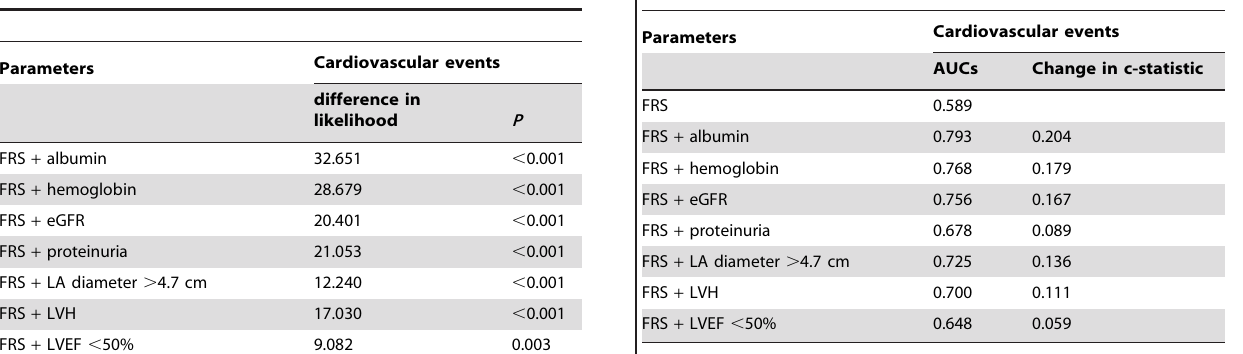
Table 3. Incremental values of biomarkers and echocardiographic parameters for cardiovascular events when added to the FRS model using Cox proportional hazards model.